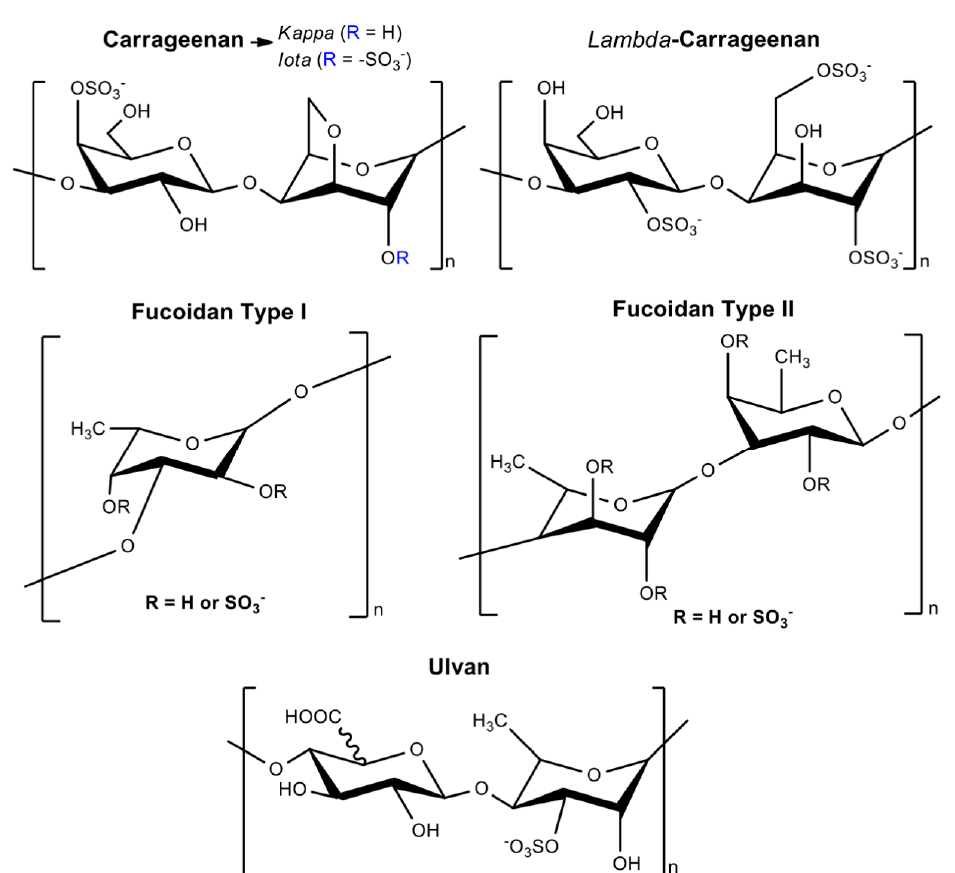
Figure 5. Chemical structures of sulfated marine polysaccharides. Adapted with permission from [7,101], published by Elsevier, 2019 and 2020.